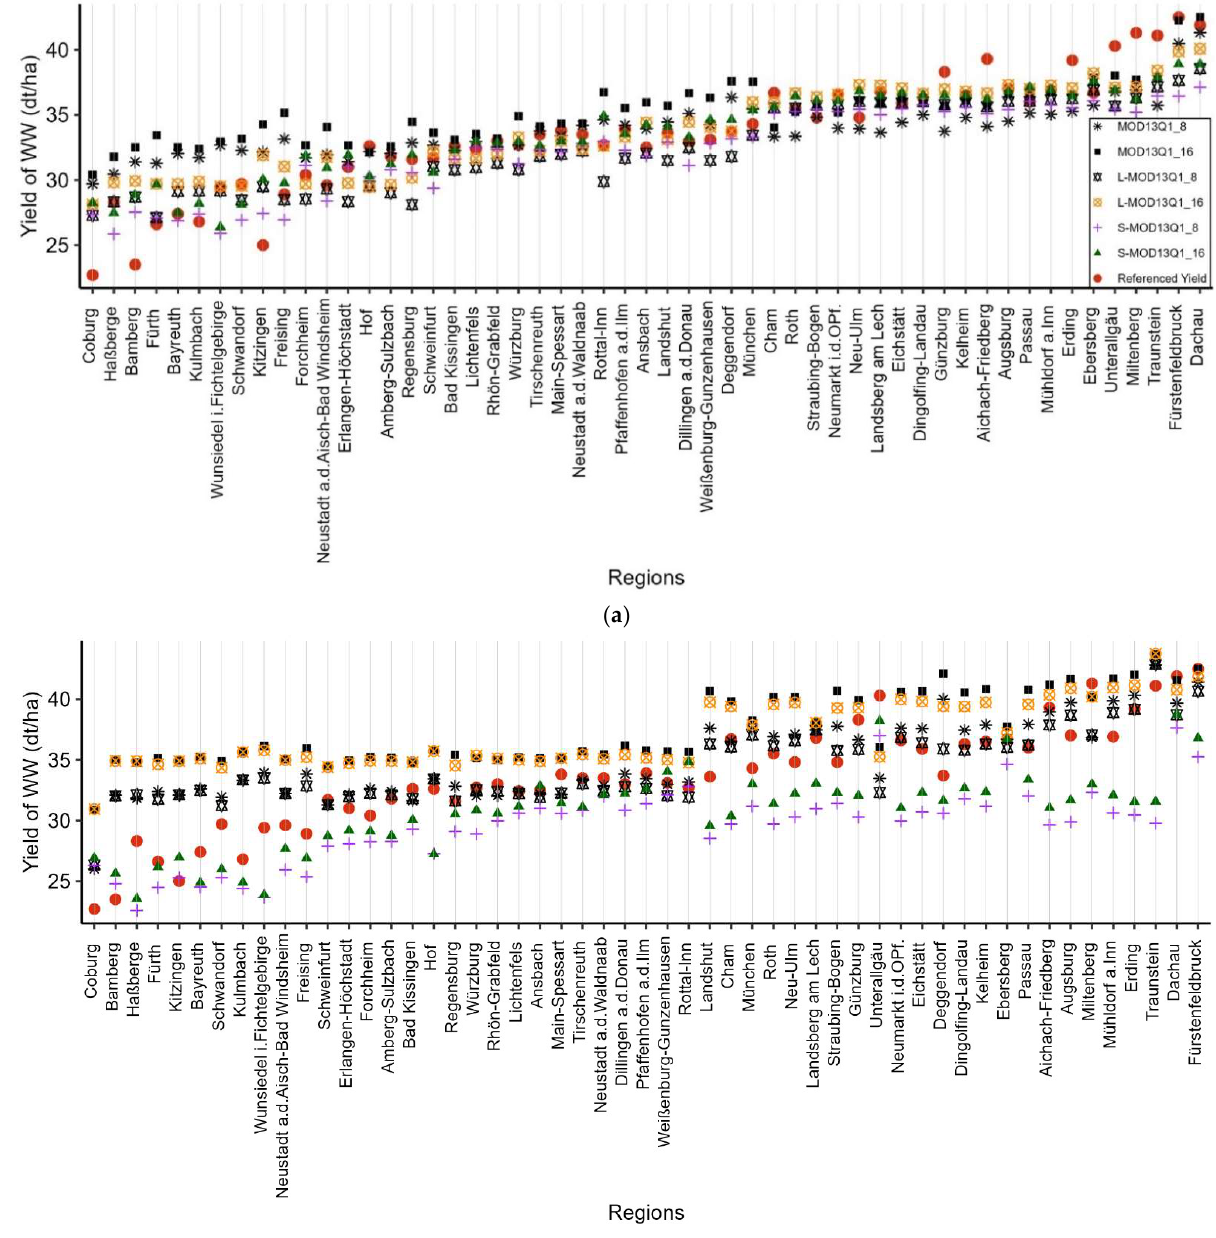
Figure 13. The dot plots show the region-wise distribution of referenced yields and modelled yields obtained from multi-source data (MOD13Q1 (8 and 16 days), L-MOD13Q1 (8 and 16 days), and S-MOD13Q1 (8 and 16 days)) for OSR using ( a ) LUE and ( b ) WOFOST in 2019. The regional referenced yields are displayed in red dots.